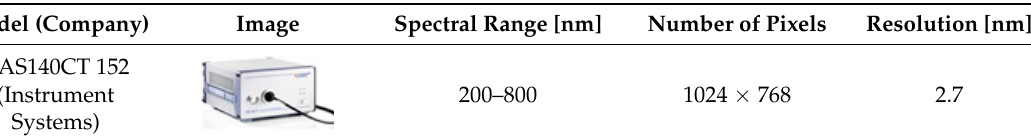
Table 1. Specifications of the spectrometer (CAS 140CT 152).